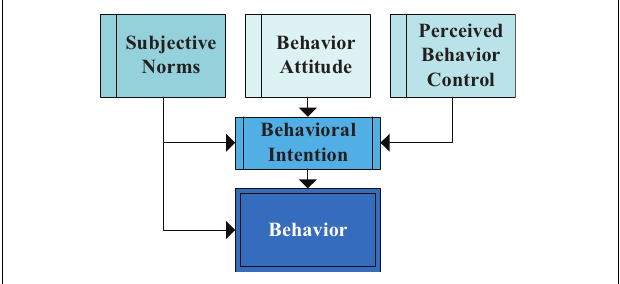
FIGURE 1 | The model of planned behavior theory.